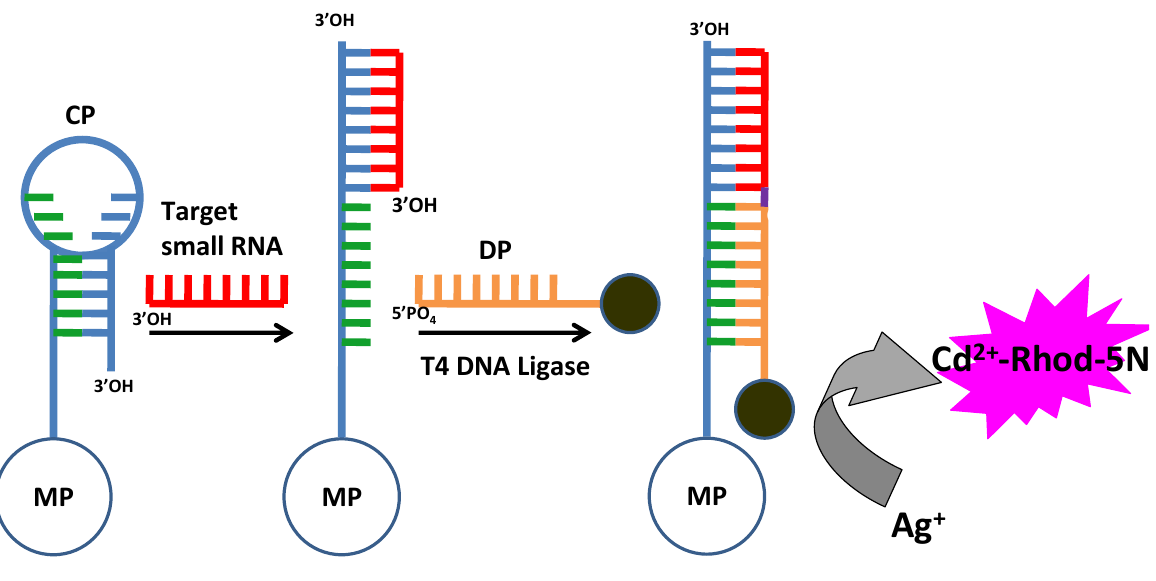
Figure 7. Schematic presentation of the small RNA detection assay using CXFluoAmp. MP: magnetic particles; CP: capture probe; DP: detection probe. Reprinted with permission from [49]. Copyright 2009 American Chemical